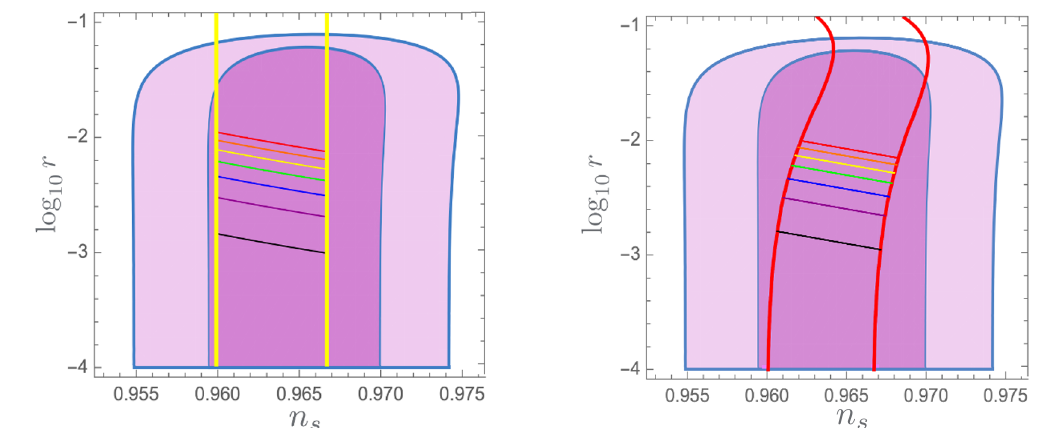
Figure 17 . α -attractor inflationary models benchmarks originating from M-theory and octonions, as derived here in section 4 and as plotted in [9]. The simplest T-models derived here in section 7.3 are shown on the left, the simplest E-models, derived in section 7.2 are on the right panel. The 7-disk model [6–8] allows 7 discrete values: 3 α = 7 , 6 , 5 , 4 , 3 , 2 , 1 . The predictions are shown for the number of e-foldings in the range 50 < N e < 60